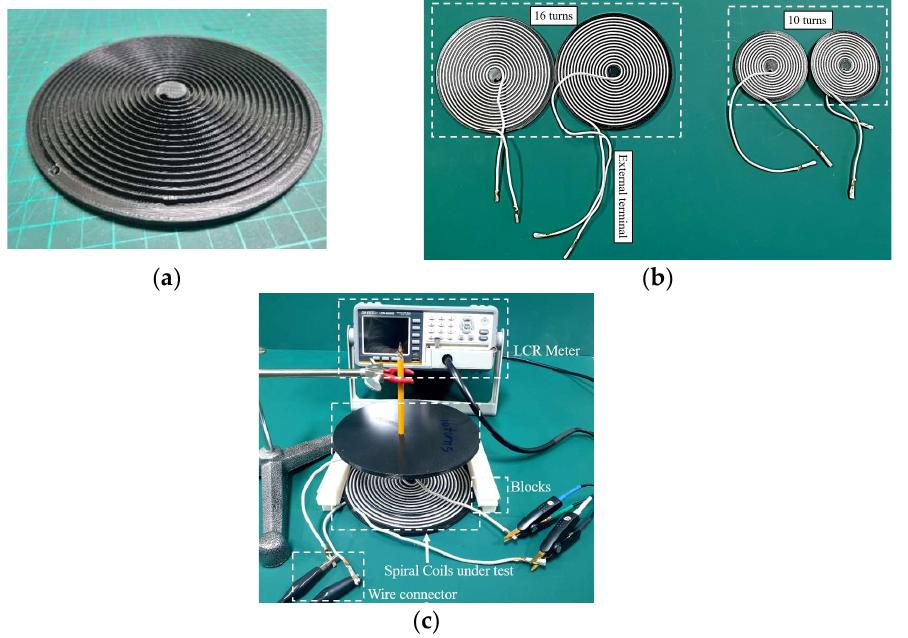
Figure 3. Experimental setup for measuring mutual inductance. ( a ) Bobbin. ( b ) Spiral coil with bobbin. ( c ) Measuring components.